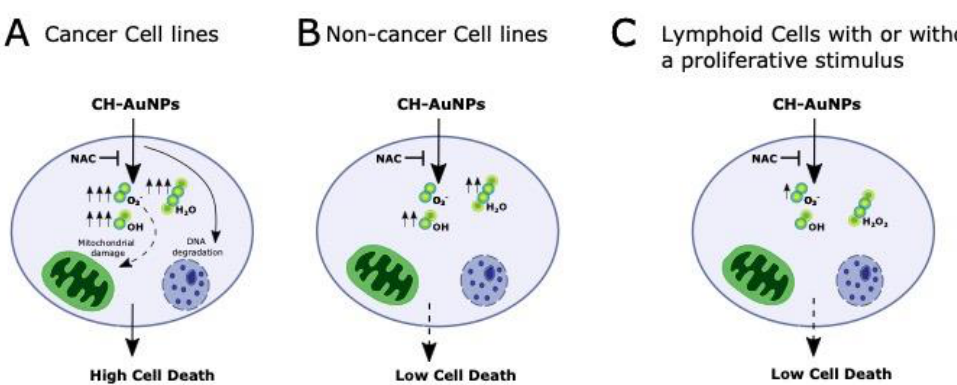
Figure 7. Schematic representation of CH-AuNPs’ effect on cancer and non-cancer cells. ( A ) In cancer cells, CH-AuNPs induced a loss of mitochondrial membrane potential and DNA degradation [17,18], and enhanced intracellular ROS production (O 2− , •OH and H 2 O 2 ). ROS were inhibited using NAC, which avoided cell death. ( B ) In non-cancer cell lines, CH-AuNPs enhanced •OH and H 2 O 2 production (inhibited by NAC), leading to cell death. ( C ) In lymphoid cells, with or without proliferative stimulus, CH-AuNPs enhanced a slight O 2− production, which was inhibited by NAC.